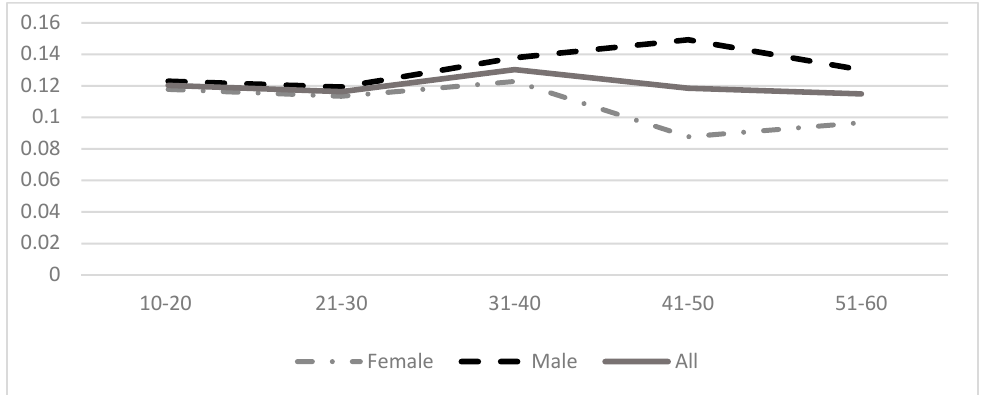
Figure 7. Studies at six Vilnius sites measured anger among males, females, and overall. These studies indicate a more or less inverse U-shape for anger by age groups.